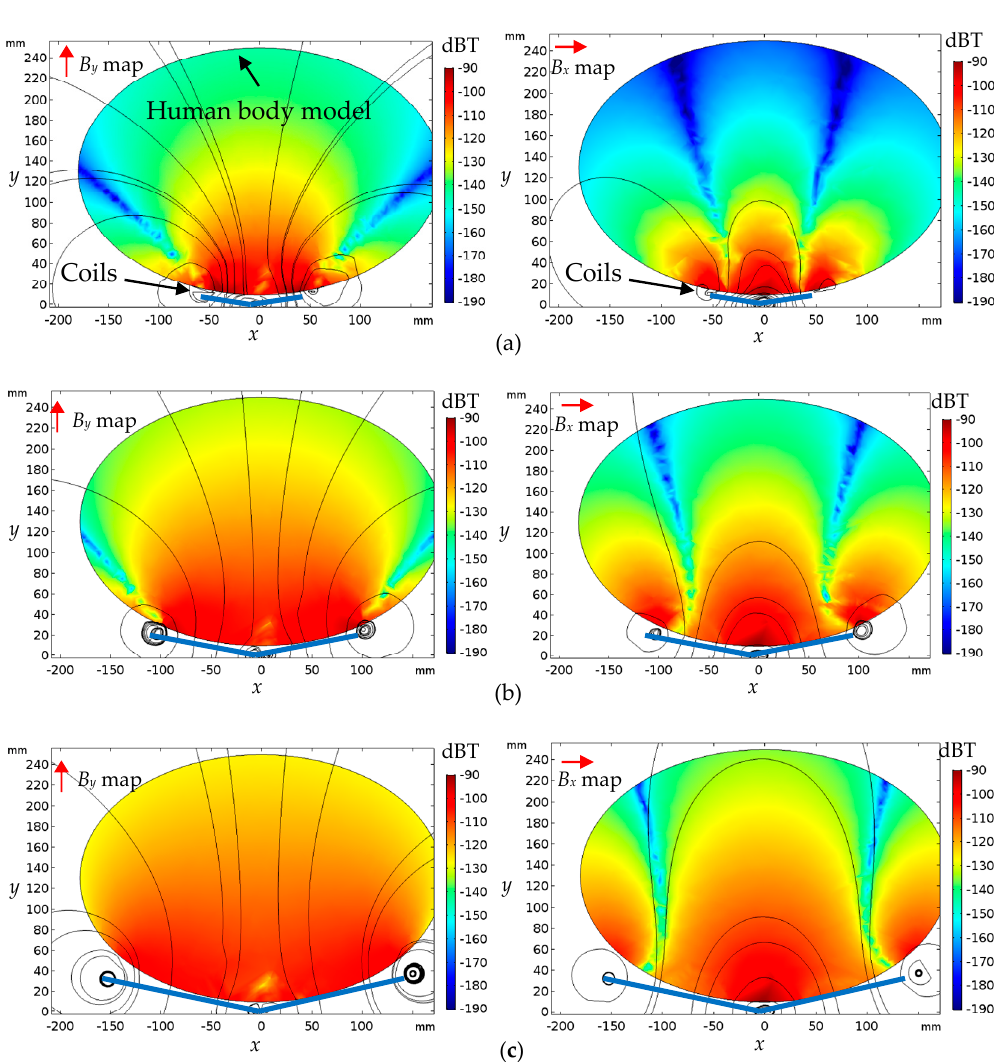
Figure 7. Strength lines and amplitude maps of B y (series excited, on the left) and B x (antiseries excited, on the right) for different coil side length: l b = 50 mm ( a ), l b = 100 mm ( b ) and l b = 150 mm ( c ).